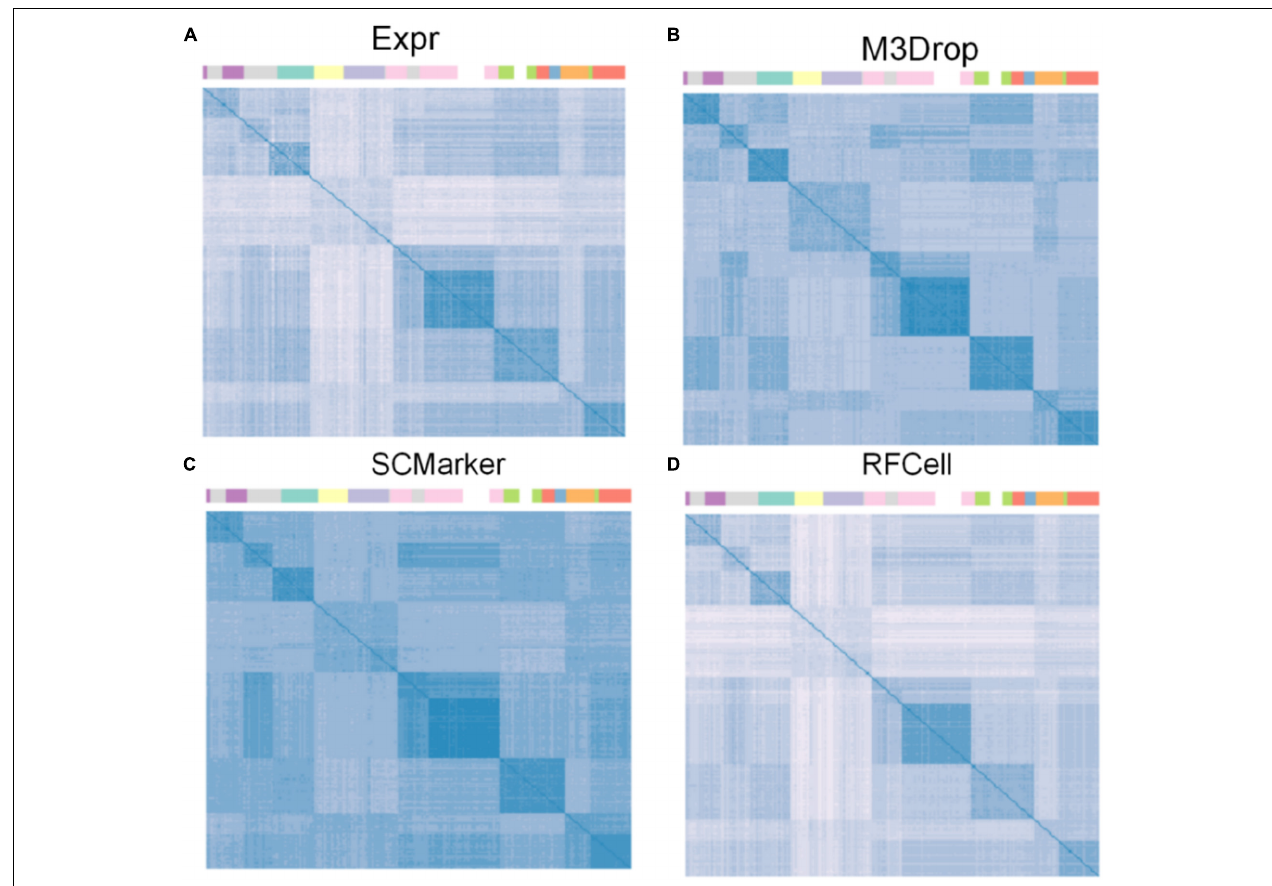
FIGURE 5 | The heat map of the result is derived from the spearman similarity measure of the gene set obtained after the gene selection of pollen data by four gene selection methods. The cells in the matrix are sorted by their true labels so that cells of the same type are adjacent. Cell clusters are clearly indicated by colored bars. (A) Heat map of the gene set obtained by the Expr gene selection; (B) Heat map of the gene set obtained by the M3Drop gene selection; (C) Heat map of the gene set obtained by the SCMarker gene selection; (D) Heat map of the gene set obtained by the RFCell gene selection.